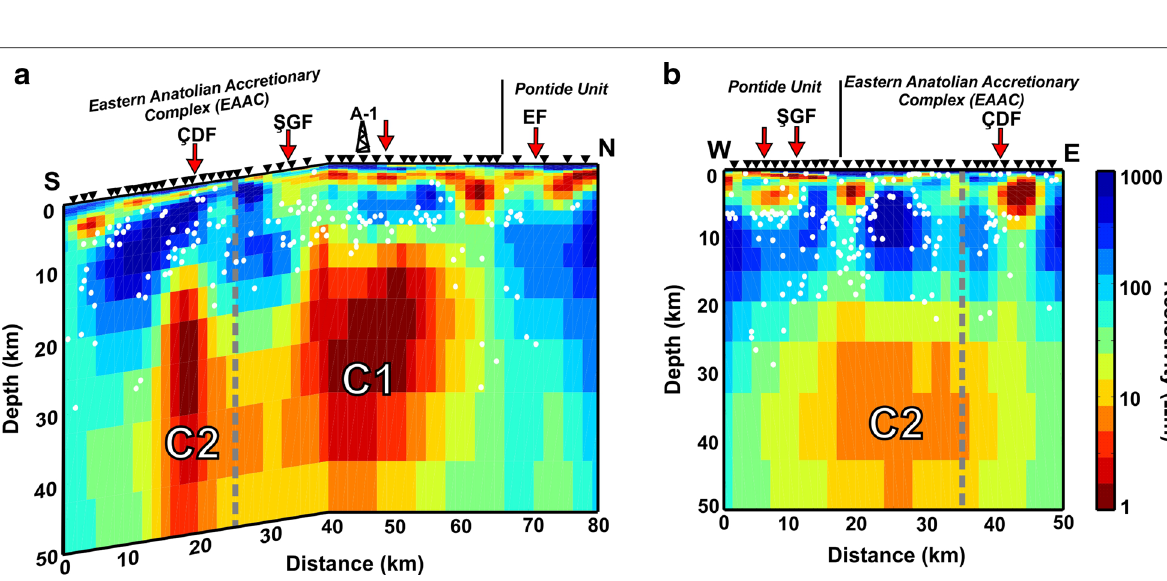
Fig. 5 G1 ( a ) and G2 ( b ) profile cross sections derived from 3D model. The surface trace of the faults (modified from Koçyi ğ it et al. 2001) is shown on the profiles as red arrows. The gray broken line represents the intersection of the profiles. The white dots indicate hypocenters of earthquakes. The earthquake hypocenters from 1900 to 2017 earthquake catalog prepared by the Kandilli Observatory and Earthquake Research Institute (KOERI) were projected onto profile cross sections. Earthquake hypocenters up to 35 km from the MT profiles were projected at right angles onto the cross